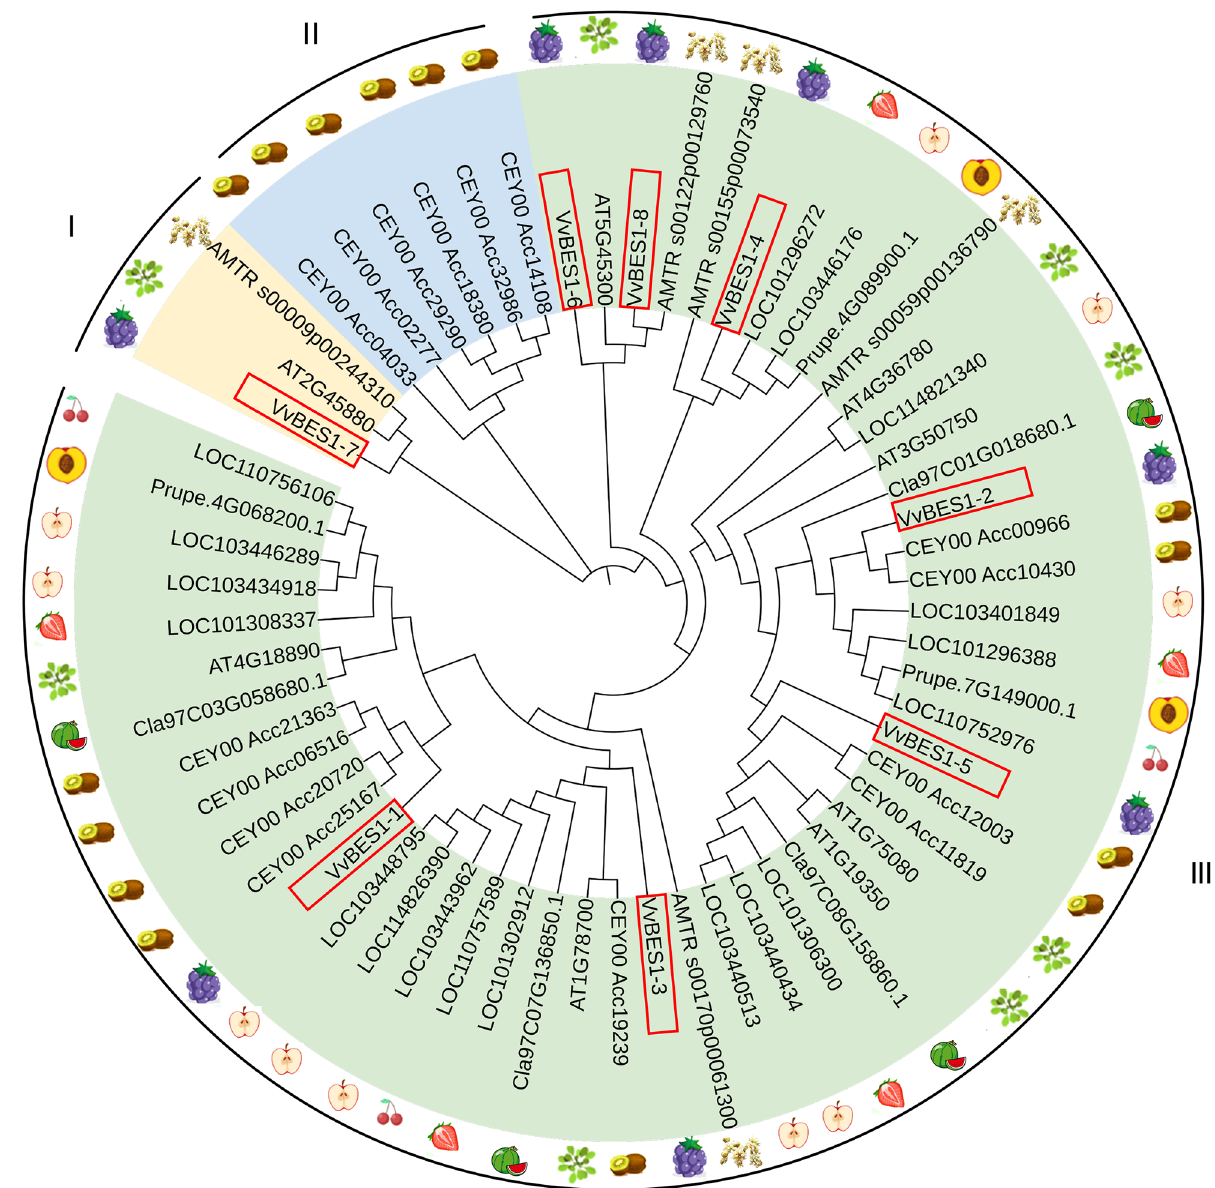
Figure 1. Phylogenetic analysis of BES1 gene family; gene information is from V. vinifera , A. thaliana , A. trichopoda , A. chinensis , F. ananassa , C. lanatus , M. pumila , P. persica , and Prunus . The neighbor-joining tree was generated from eight BES1 genes from V. vinifera , eight BES1 genes from A. thaliana , five BES1 genes from A. trichopoda , fifteen BES1 genes from A. chinensis , ten BES1 genes from M. pumila , three BES1 genes from P. persica , and three BES1 genes from Prunus , five BES1 genes from F. ananassa , four BES1 genes from C. lanatus